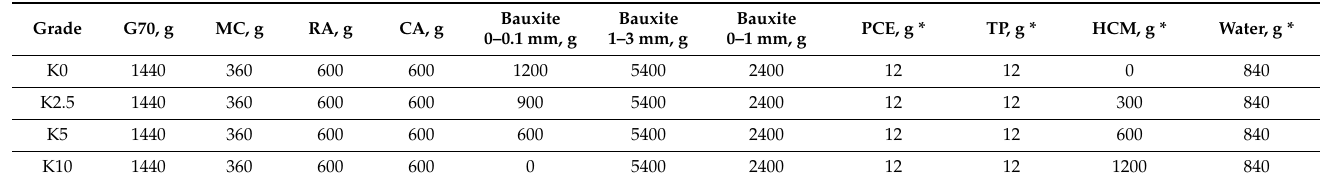
Table 1. Composition of